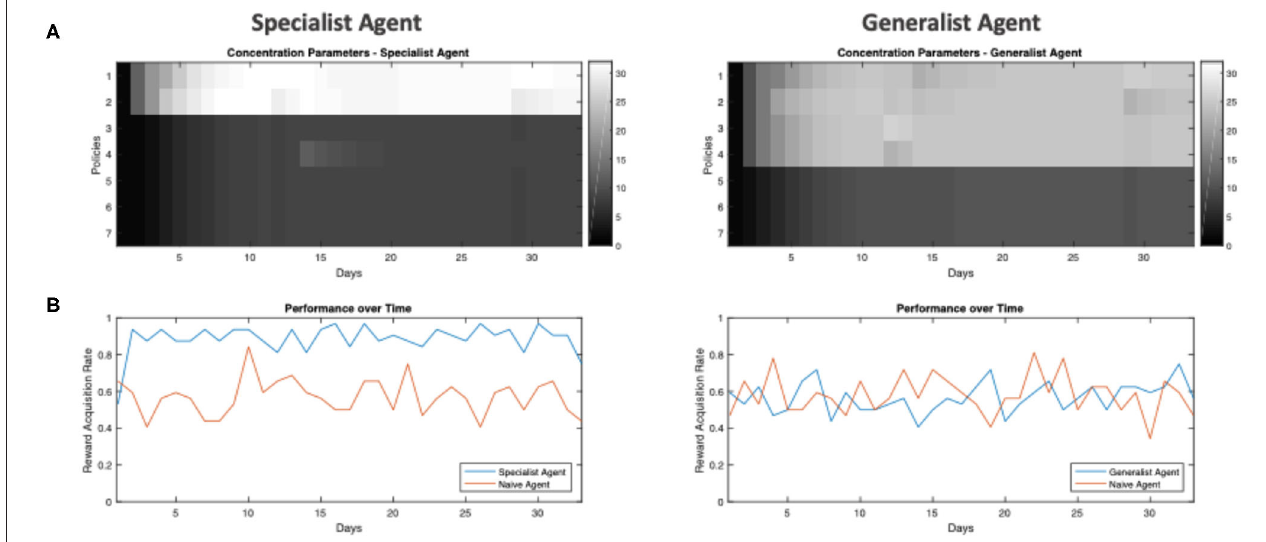
FIGURE 5 | Example performance of in-training agents over days. (A) Heat-map of e concentration parameters for each policy (separated by rows) over all 32 days of training (separated by columns). (B) The frequency at which the agent is able to get to the reward location when tested under ambiguity. This simulated testing is done after each day of training, where each agent is tested under ambiguity (the agent is 65% sure it sees the correct cue) for 32 trials, where the reward location / frequency in the testing environment is identical to the environment in which the agent is trained (i.e., a specialist agent is tested in an environment with low volatility and the reward always being on the left of the initial location). The frequency is computed from how many out of the 32 trials the agent is able to get to the true reward